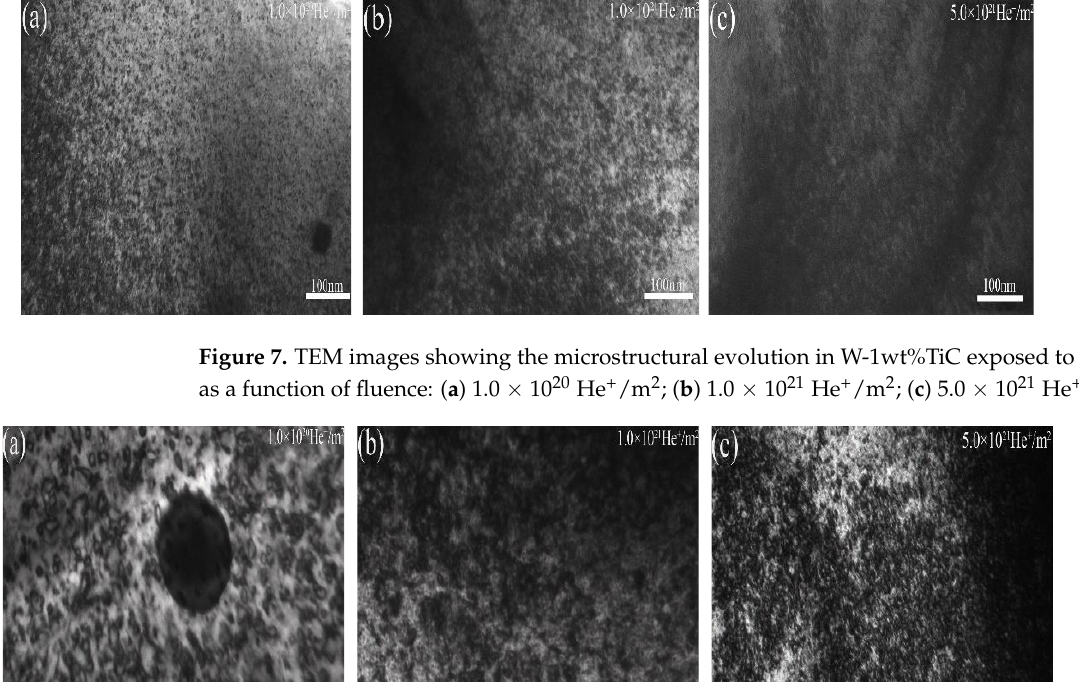
7 of 12 Figure 6. TEM images showing the microstructural evolution in pure W exposed to 5 keV He + as a function of fluence: ( a ) 1.0 × 10 20 He + /m 2 ; ( b ) 1.0 × 10 21 He + /m 2 ; ( c ) 5.0 × 10 21 He + /m 2 . Defect formation and evolution were also observed in doped W under He + ion irra- diation, shown in Figures 7 and 8, respectively. At a low dose of 1.0 × 10 20 He + /m 2 , the microstructure was characteristic of small dislocation loops, which were randomly dis- tributed inside both W-1wt%TiC and W-1wt%ZrC samples. The size of dislocation loop in different irradiated samples was completely different. The number densities of W- 1wt%TiC were on the order of 1.0 × 10 23 , higher than that of W-1wt%ZrC with 1.0 × 10 22 . The dislocation loops in W-1wt%TiC samples showed a fine dispersion distribution, and the average dislocation loop size was 2.1 nm, which was much smaller than W-1wt%ZrC of 12.8 nm, as shown in Table 2. The produced interstitial-type dislocation loops increased in density and tangled with each other as the fluences increased, which made it extremely difficult to distinguish individual dislocation loops at 1.0 × 10 21 He + /m 2 . At end fluence of 5.0 × 10 21 He + /m 2 , the loops piled up as tangled dislocations. However, no helium bubbles were observed at all in W-1wt%TiC and W-1wt%ZrC as the He + implantation dose in- creased, indicating that carbide doping could enhance the radiation tolerance of W to He +